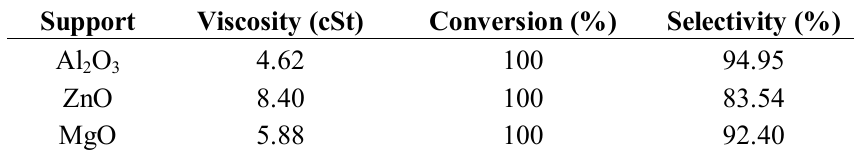
Table 1. Reactions performed under standard conditions, using 12 mL of sunflower